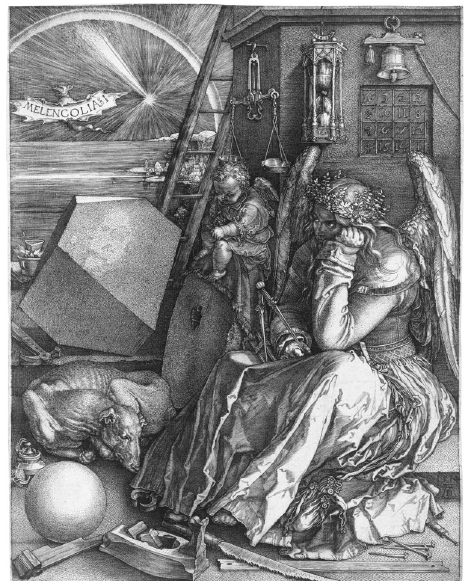
Fig. 1. Albrecht Dűrer’s Melancholy (source: